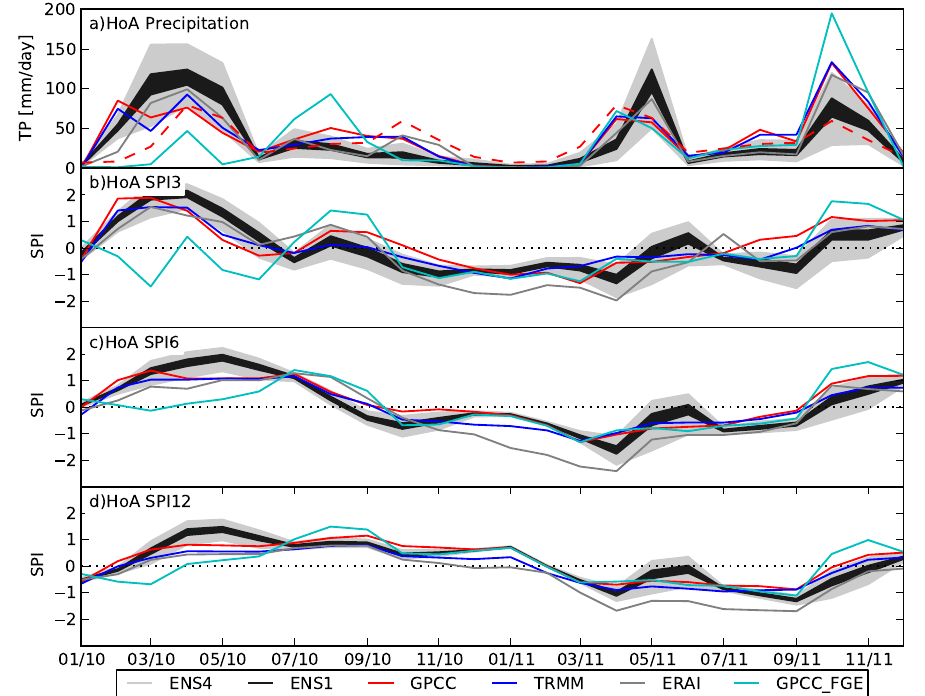
Figure 9. Spatial averages over the Horn of Africa region (3 ◦ S–12 ◦ N, 40–52 ◦ E) of (a) total precipitation, (b) SPI-3, (c) SPI-6 and (d) SPI- 12 for the different monitoring products: GPCC_FD (red), TRMM (blue), ERAI (dark grey), GPCC_FGE (cyan). The probabilistic ENS data in shading ranges from the minimum to the maximum (light grey for original ENS and black for the ENS with 4 times spread inflation). In panel (a) the GPCC mean annual cycle is represented by the dashed red